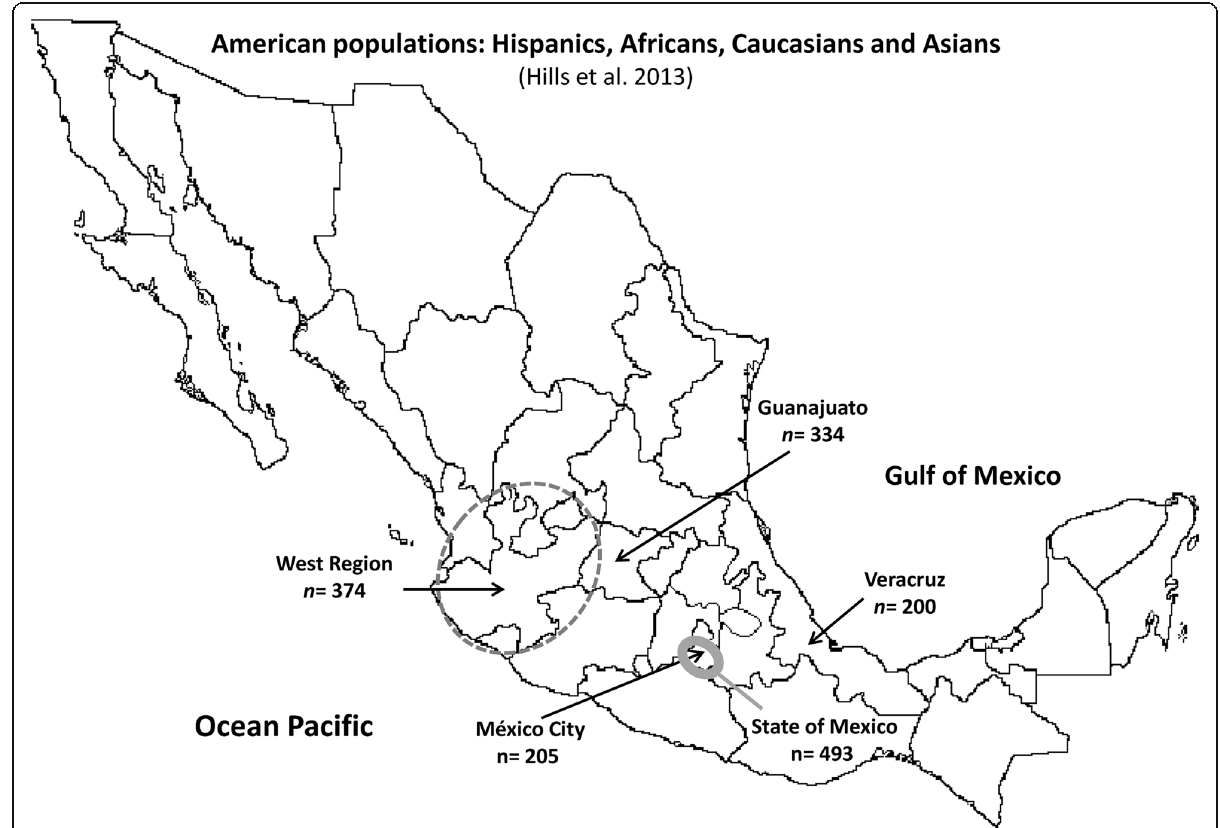
Fig. 1 Geographic location and sample size of the Mexican-Mestizo populations used for interpopulational analysis in this